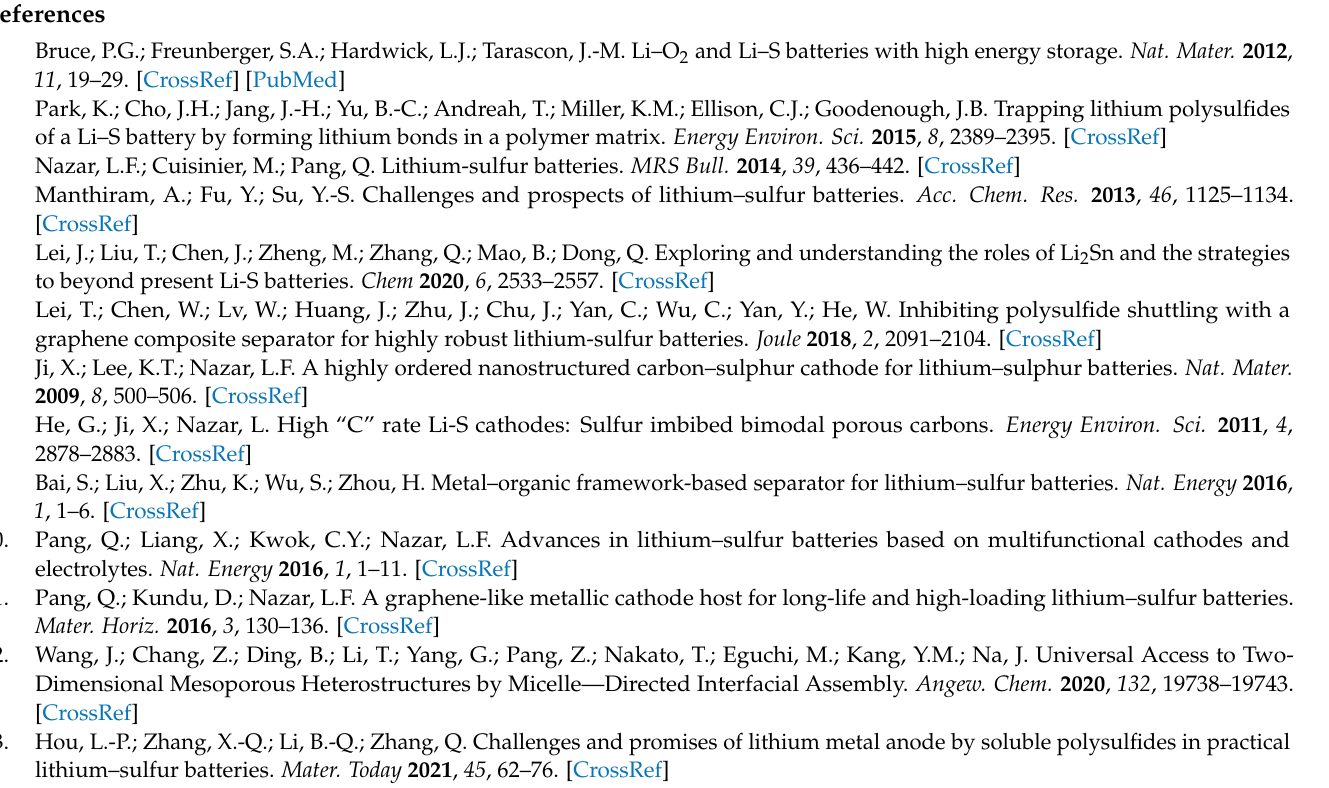
Figure S2: TGA curve; Figure S3. SEM images of separators; Figure S4: SEM image and EDX mapping; Figure S5: Contact angle measurements; Figure S6. I-t curves and Impedance plots. Figure S7: SEM images, XRD patterns and TGA curve of Super P/S composite. Figure S8: CV curves and plots of peak current vs. square root of scan rates. Figure S9: Galvanostatic discharge-charge profiles. Figure S10: SEM images of the separator after cycling. Table S1: Summary of lithium ion diffusion coefficient; Table S2: Electrochemical performance of Li–S batteries by using various modified